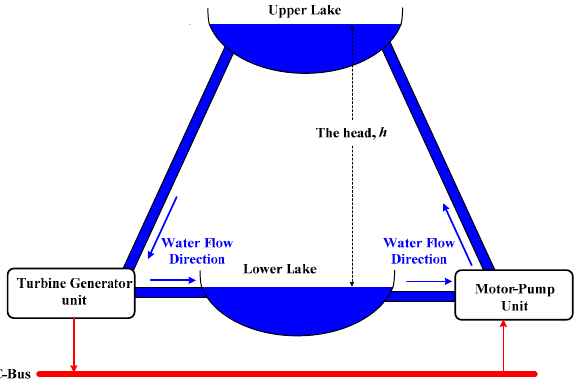
Figure 4. The water and electric power flow through the pumped storage system.